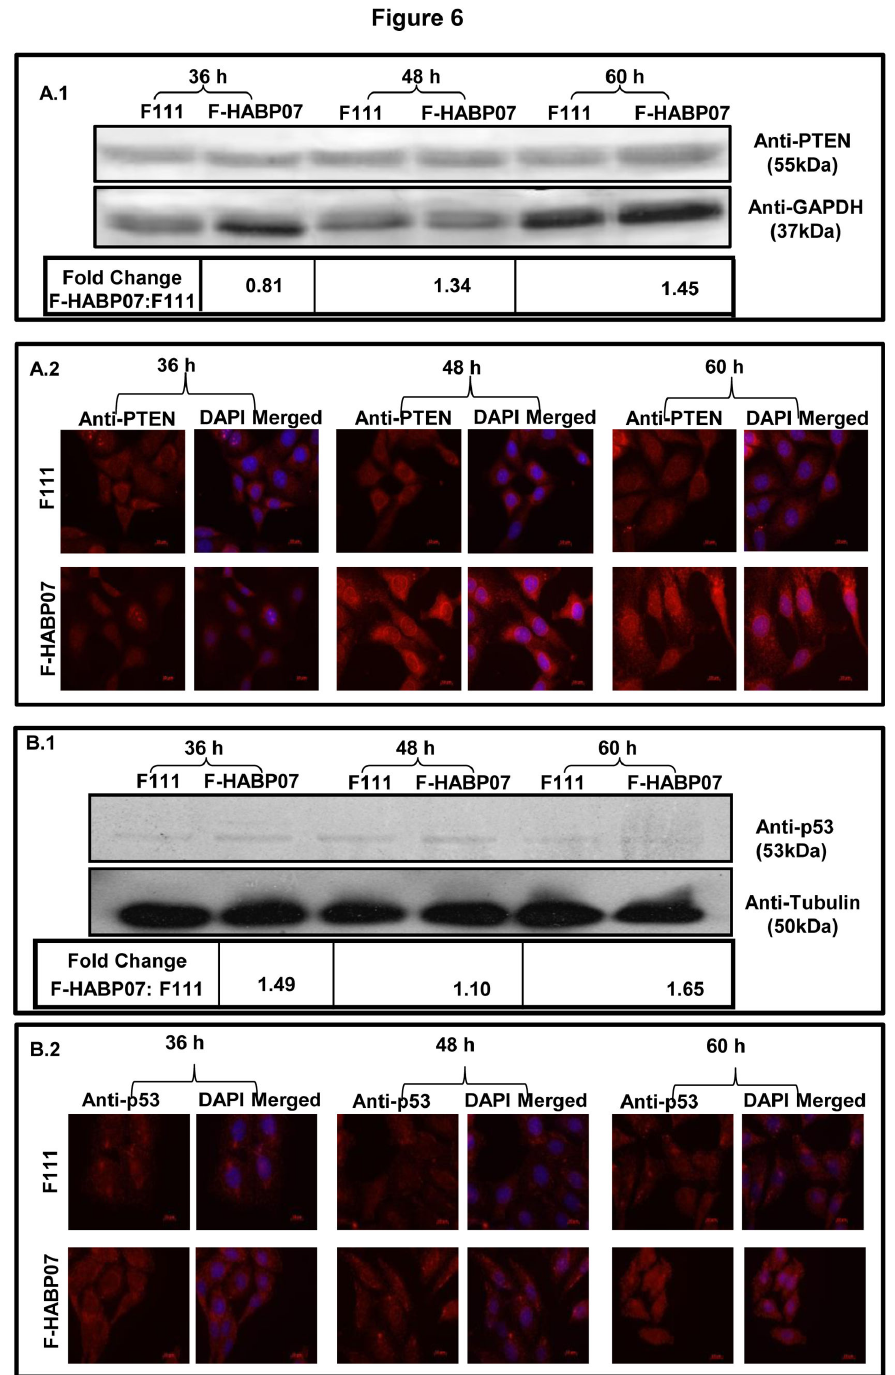
Figure 6. Upregulation of tumor suppressors in the HABP1 transformed fibroblast F-HABP07. Whole cell lysates of F111 and the HABP1 transformed fibroblast cells (F-HABP07) were resolved by SDS-PAGE, transferred and immunoblotted with antibodies for the tumor suppressors PTEN ( A .1) and p53 ( B .1). Expression of PTEN which was initially lower in F-HABP07 gradually increased with progression of growth from 36 to 60 h. This coincides with the immunocytochemical data which also show nuclear localization of PTEN at 48 and 60 h of growth ( A .2). p53 expression increased in F-HABP07 cells at 60 h of growth. Immunocytochemical analysis of F111 and F-HABP07 cells grown for the three time periods shows a higher expression and nuclear localization of p53 at 60 h of growth, indicating an activated state in F-HABP07 cells ( B .2). doi: 10.1371/journal.pone.0078131.g006 PLOS ONE |